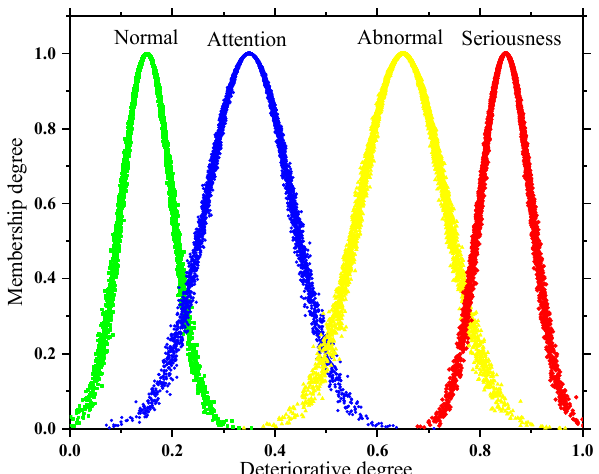
Figure 2. State space of quantitative indicator.